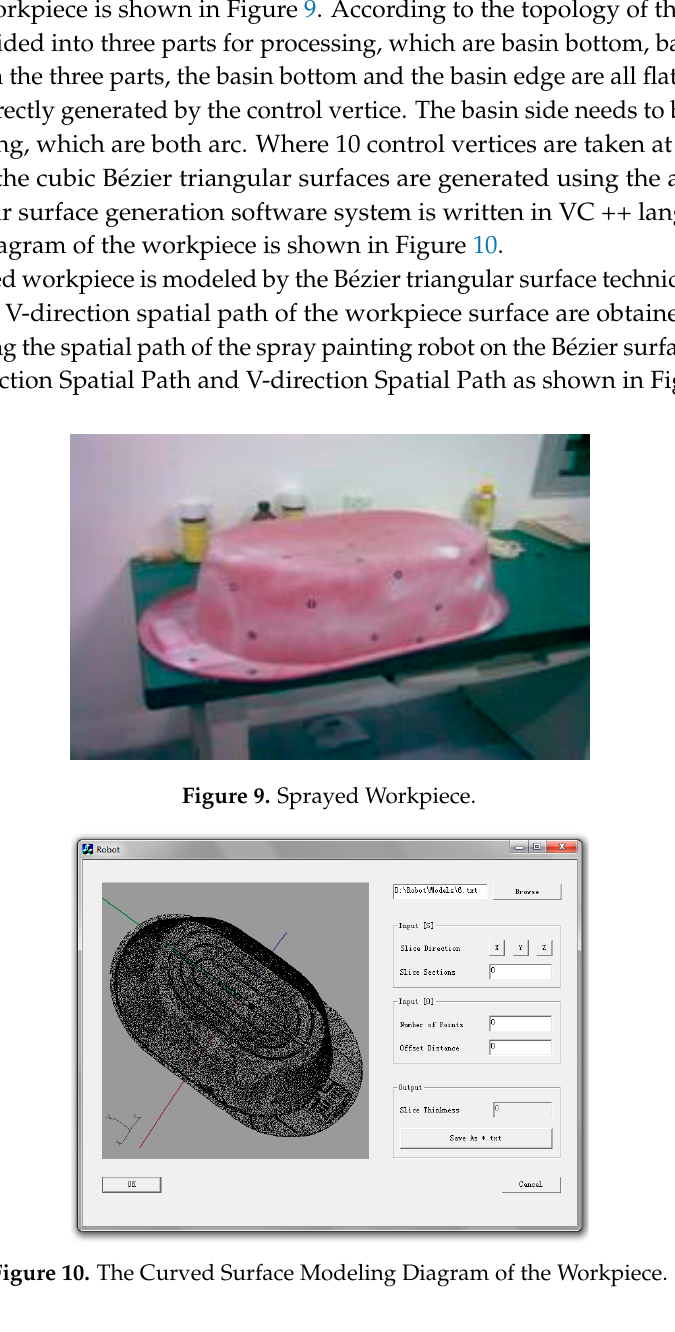
Figure 11. U-direction Spatial Path.